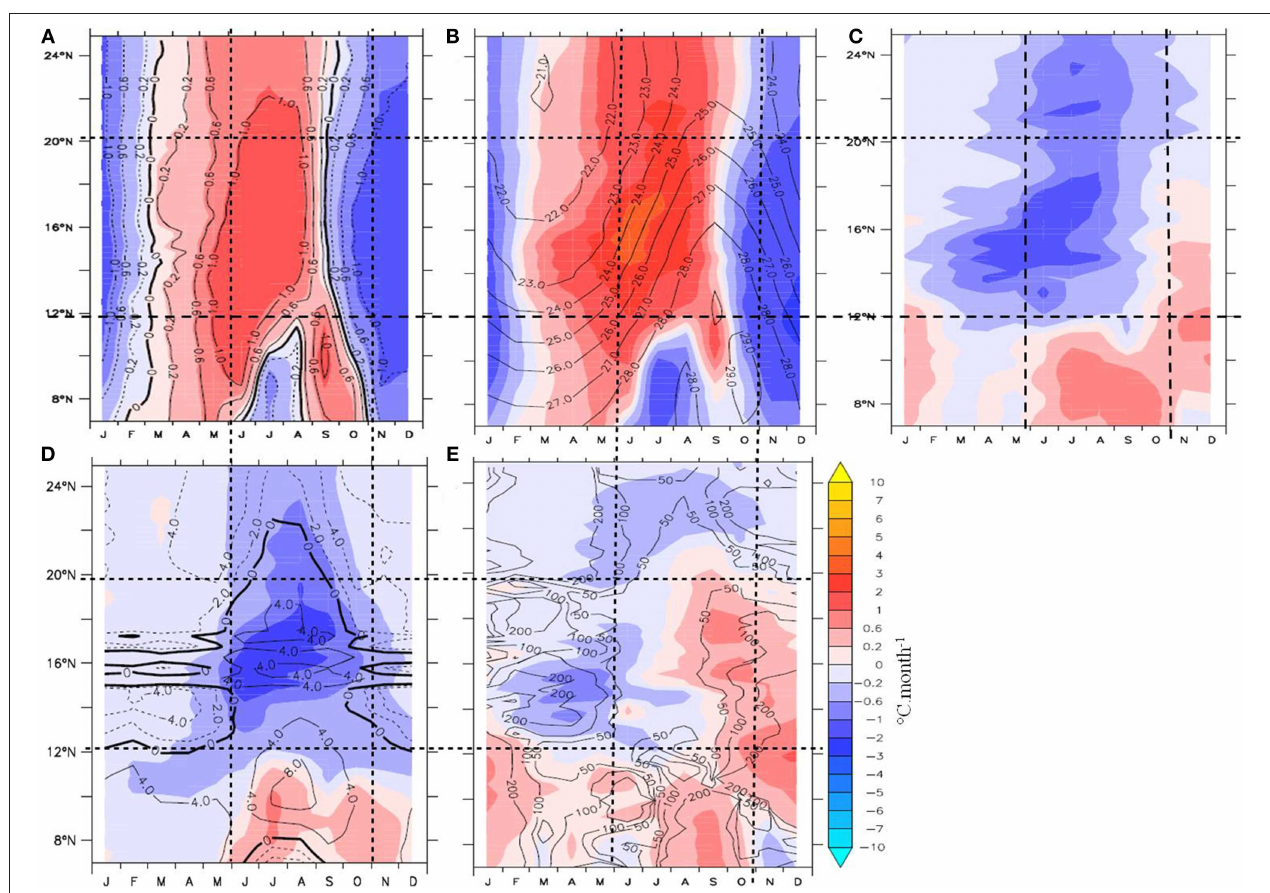
FIGURE 14 | Same as in Figure 13 but for the heat budget terms averaged between18 ◦ W and 26 ◦ W.